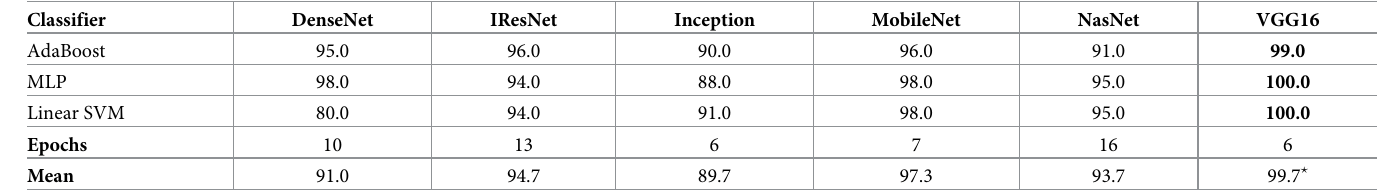
Table 2. Mean accuracies of the experiments based on deep learning features obtained with the tested convolutional neural network architectures (DenseNet, IRes- Net, Inception, MobileNet, NasNet, and VGG16) for the stomata classification task.